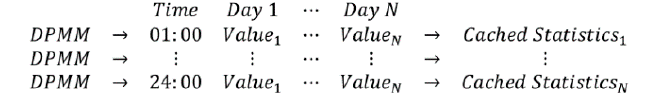
Figure 5. Graphical representation of the Chinese Restaurant Process (CRP).